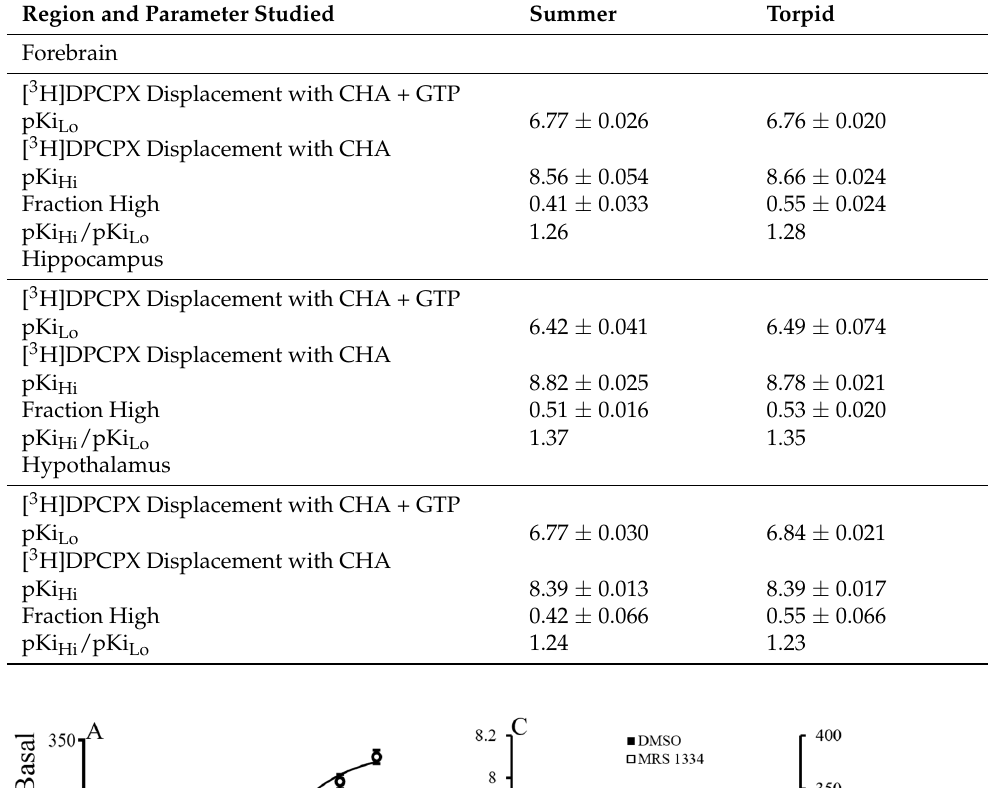
Table 1. Characterization of CHA binding in summer and torpid AGS.